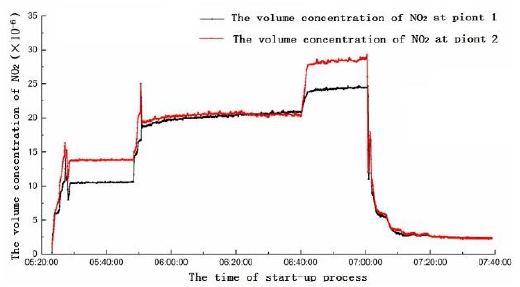
Figure 14. NO 2 measurements at Point 1 and Point 2.